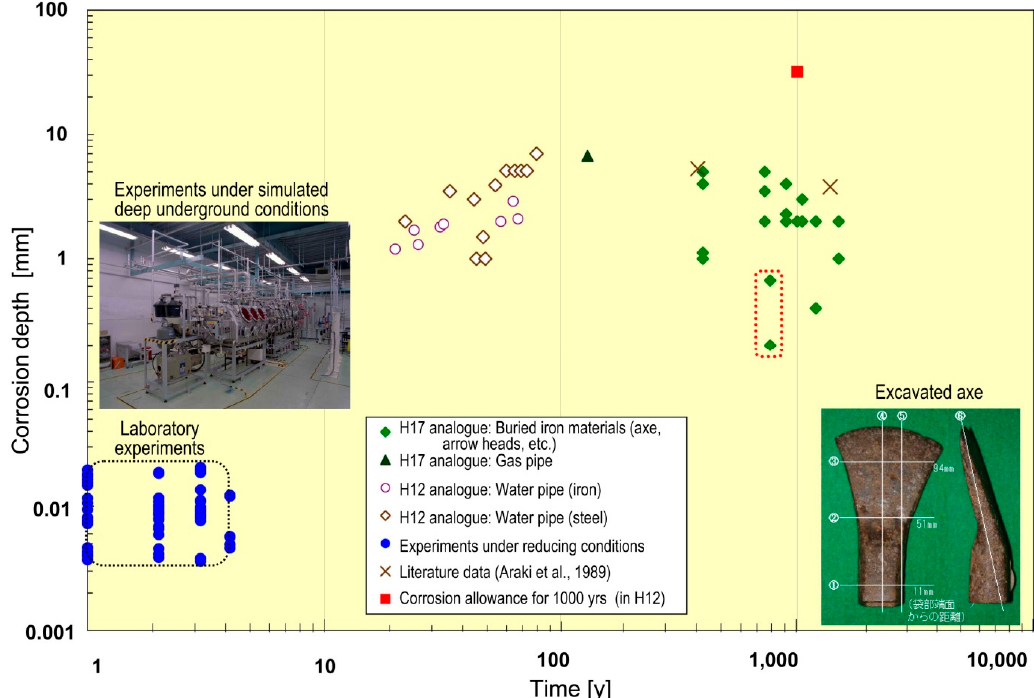
Figure 2. Integration of iron/steel corrosion data from laboratory experiments and several natural analogue sources (details in [19,21]). Note that the H17 analogues surrounded by the red dots are believed to have come from an aerobic environment.